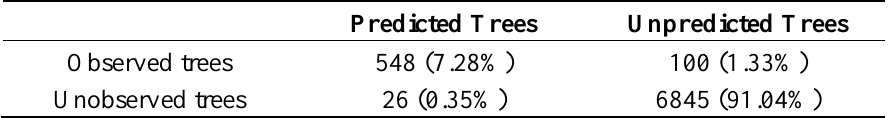
Table 8. Number and percentage of encoder events recorded in each situation during the LIDAR validation tests.